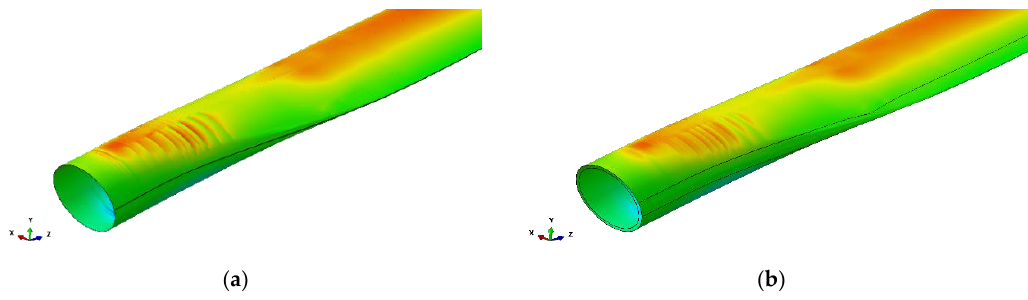
Figure 13. Contour plot of the longitudinal strain on the blade under the negative flatwise load case. ( a ) OML shell model; ( b ) layered solid model.